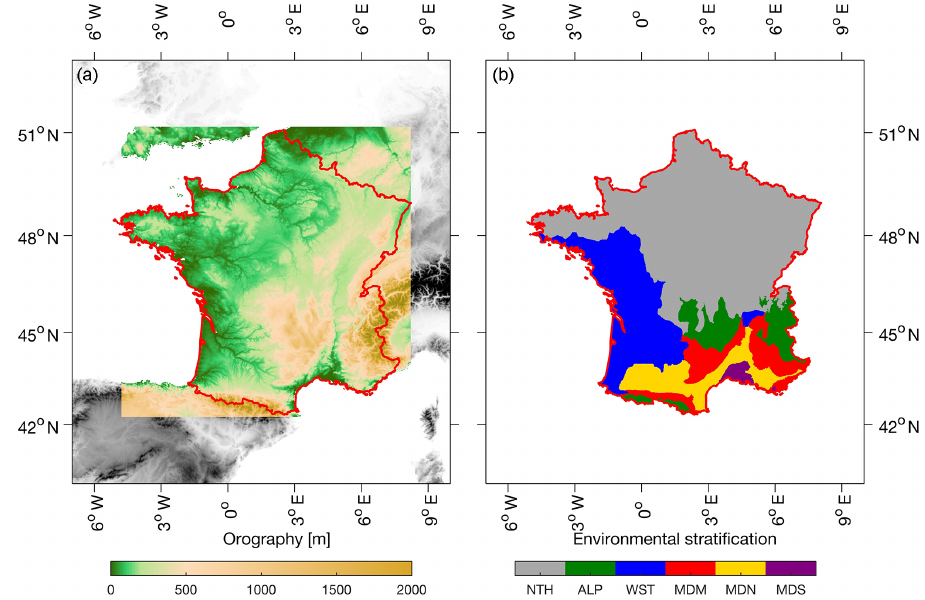
Figure 1. (a) Orography in France. The red contour shows the outlines of the investigated French region. (b) Environmental stratification based on climate data, data on the ocean influence and geographical position (Metzger et al., 2005; Jongman et al., 2006). Abbreviations are NTH – north (Atlantic central in Metzger et al., 2005), ALP – Alpine, WST – west (Lusitanean in Metzger et al., 2005), MDM – Mediterranean mountains, MDN – Mediterranean north, and MDS – Mediterranean south. Table 2. This table provides, for each environmental region, the number of wildfires, the number of large wildfires ( > 100ha), the contribution of large wildfires to regional burned area and the contribution of large wildfires to national burned area. Environment region No. wildfires No. large wildfires Contribution to regional BA Contribution to national BA North 49 6 61.8% 1.9% Alpine 41 69.1% West 101 Mediterranean mountains 289 Mediterranean north Mediterranean